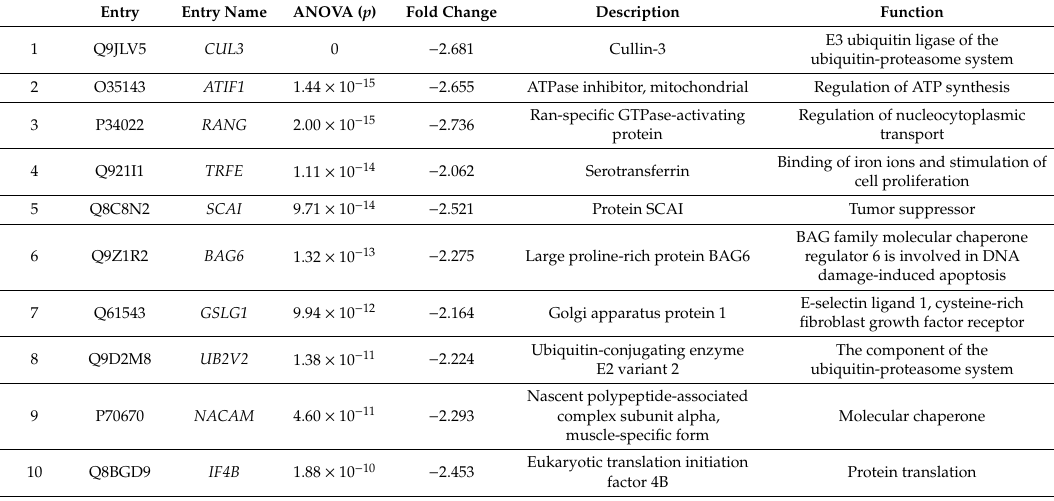
Table 1. Di ff erentially expressed proteins detected in brain hemispheres 24 h after administration of a neuroprotective dose of isatin (100 mg / kg,